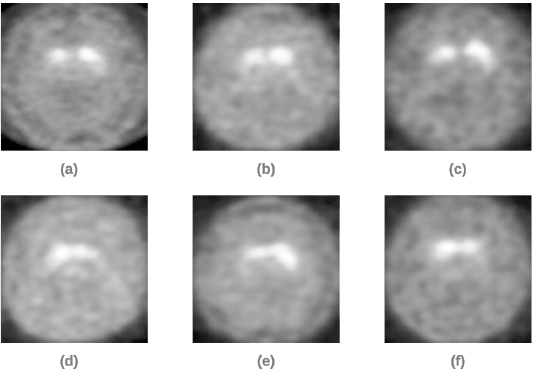
Figure 1. Sample images ( a – f ) from PPMI dataset for a person suffering from PD.